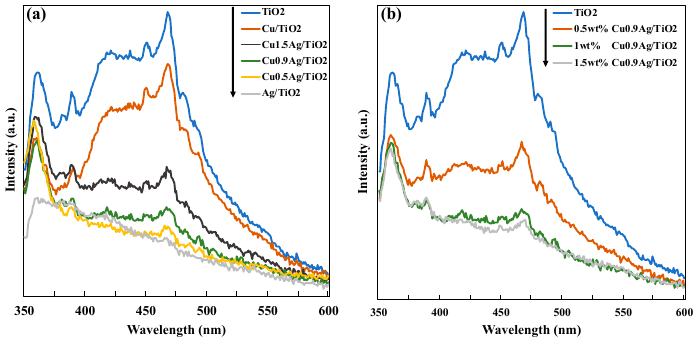
Figure 5. ( a ) Comparison of PL spectra of the different TiO 2 samples, and ( b ) effect of the loading amount of CuAg alloy onto TiO 2 .